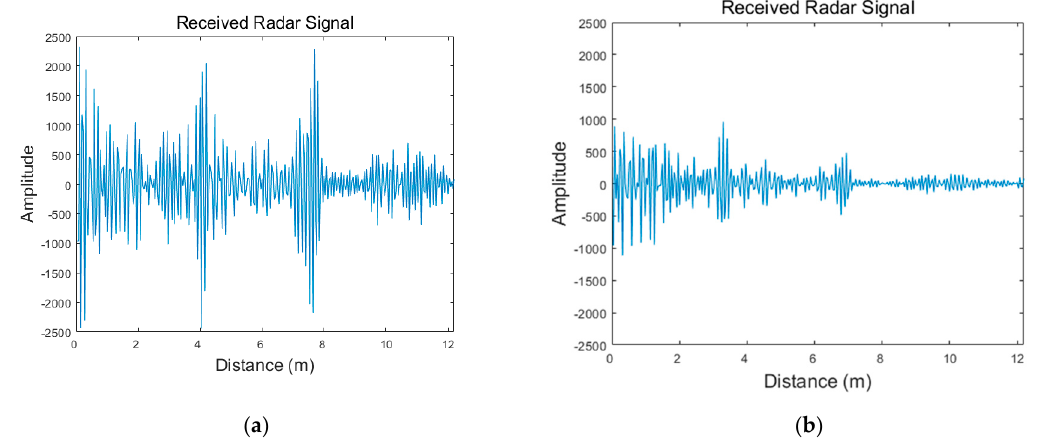
Figure 4. Radar signals at detection stage: ( a ) received radar signal with no wall; ( b ) received radar signal through the wall.